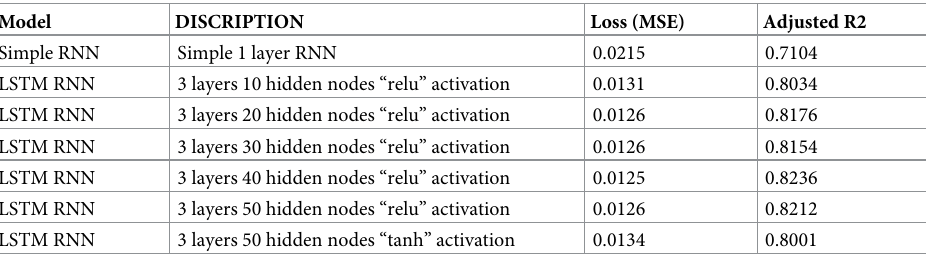
Table 3. Summary of model